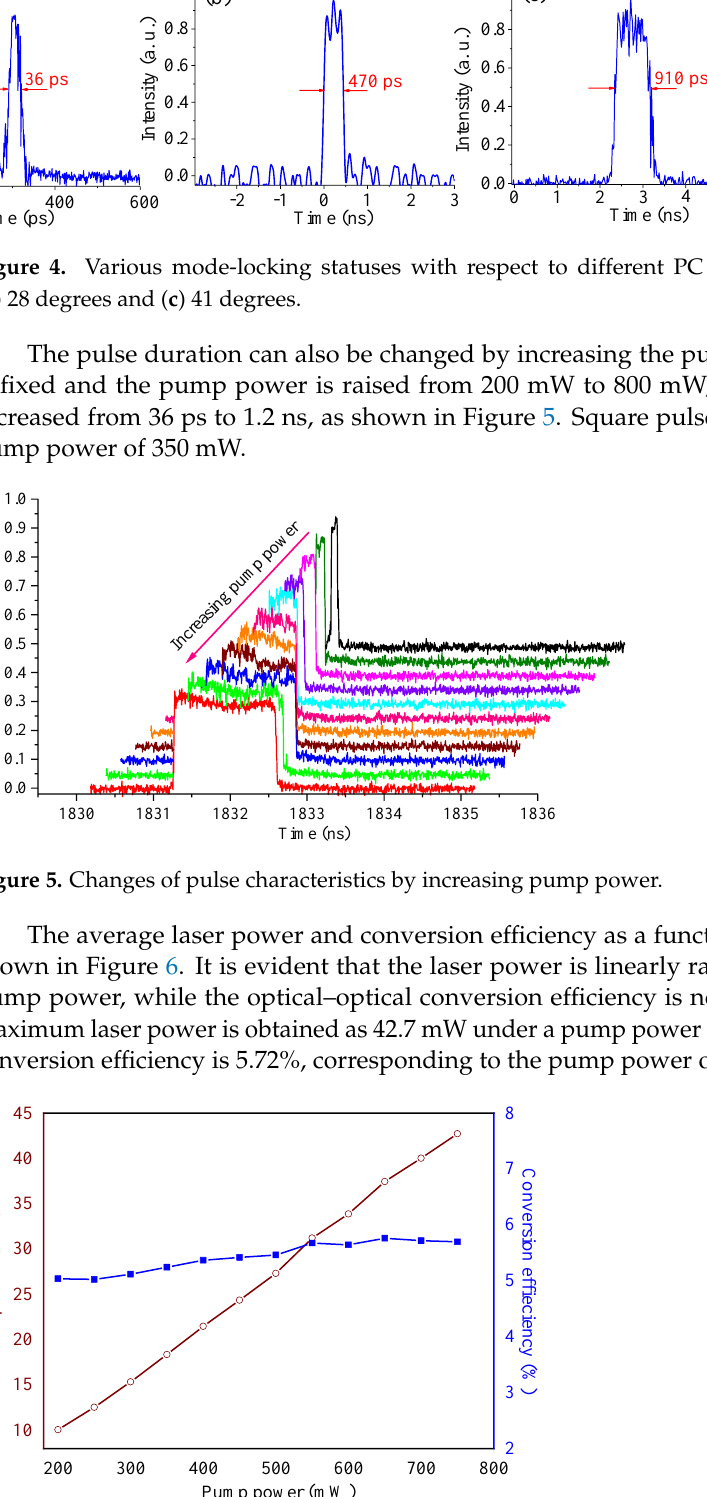
Pump power (mW) Figure 6. Average laser power and conversion efficiency with respect to pump